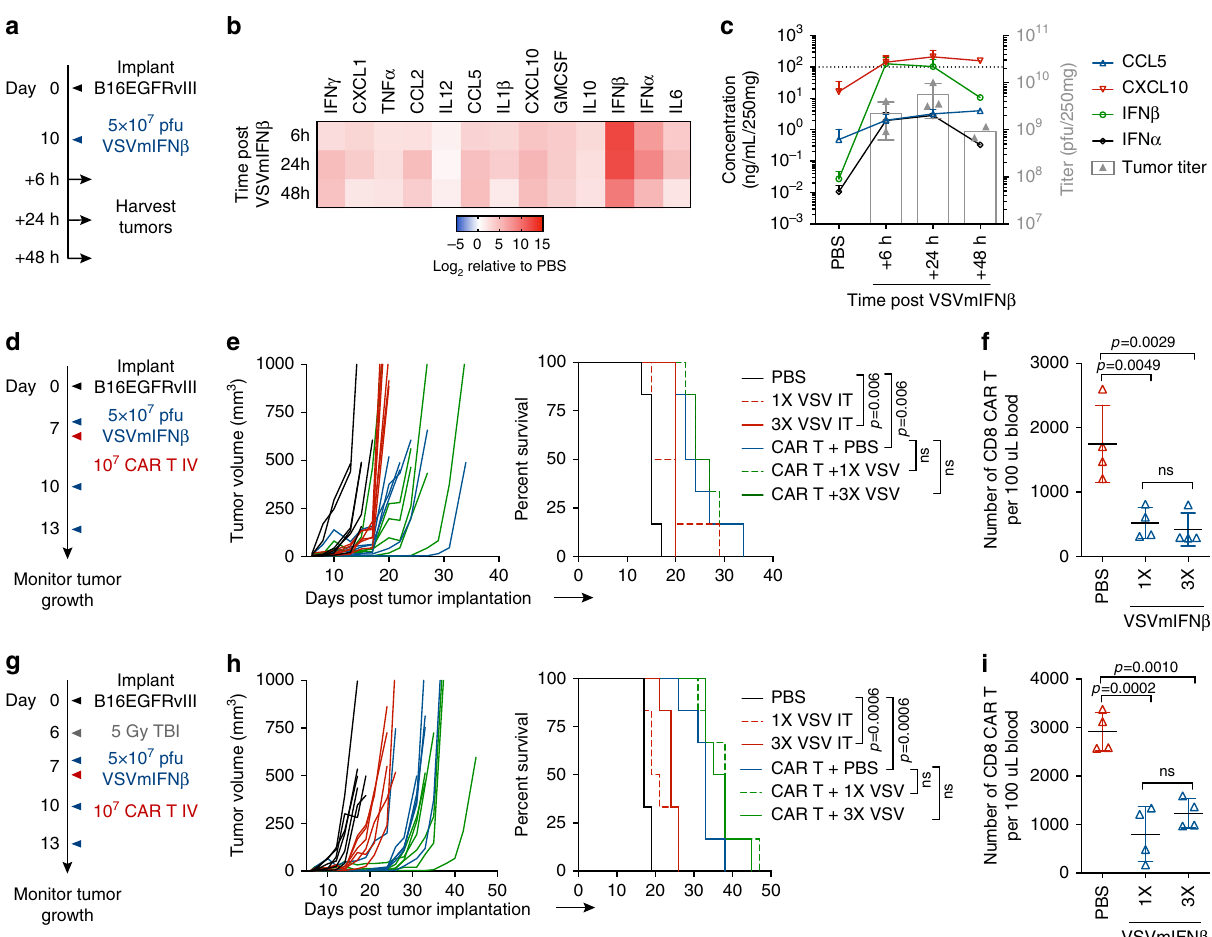
Fig. 1 Oncolytic VSVmIFN β infection promotes a favorable chemokine pro fi le for CAR T cell traf fi cking, yet combination does not improve survival. Mice bearing B16EGFRvIII tumors received a single intratumoral (IT) injection of 5 × 10 7 pfu of VSVmIFN β or PBS and tumors were harvested 6, 24 or 48 h post injection ( a ). Cytokine and chemokine concentration and infectious viral titer ( b , c ) was quanti fi ed in tumor homogenate and normalized to the average tumor weight. Mean ± SD for n = 3 per group except 48 h time point n = 2. Dashed line indicates upper limit of standard curve for quanti fi cation. d Mice bearing B16EGFRvIII tumors were treated with 5 × 10 7 pfu VSVmIFN β or PBS 6 h prior to intravenous (IV) administration of 1 × 10 7 EGFRvIII CAR T cells on day 7. Select groups received 2 additional doses of 5 × 10 7 pfu VSVmIFN β on days 10 and 13. n = 6/group. e Tumor growth for select groups is shown in the left panel and overall survival is shown in the right panel. f Circulating CD8 CAR T cells were quanti fi ed from the blood 7 days after adoptive transfer and represented as mean ± SD for n = 4/group. Each symbol represents a mouse. g Mice bearing B16EGFRvIII tumors were given a lymphodepleting dose of 5 Gy total body irradiation (TBI) on day 6 and treated with 5 × 10 7 pfu VSVmIFN β or PBS 6 h prior to administration of 1 × 10 7 EGFRvIII CAR T cells on day 7. Select groups received 2 additional doses of 5 × 10 7 pfu VSVmIFN β on days 10 and 13. n = 6/group. h Tumor growth for select groups is shown in the left panel and overall survival is shown in the right panel. Circulating CD8 CAR T cells were quanti fi ed from the blood 6 days after adoptive transfer and represented as mean ± SD for n = 4/group ( i ). Experiments were performed once. P -values were determined using the Log-rank Mantel – Cox test ( e , h ) or a one-way ANOVA with a Tukey multiple comparisons post-test ( f , i ). Statistical signi fi cance set at p < 0.05, ns > 0.05. Source data are provided in the Source Data